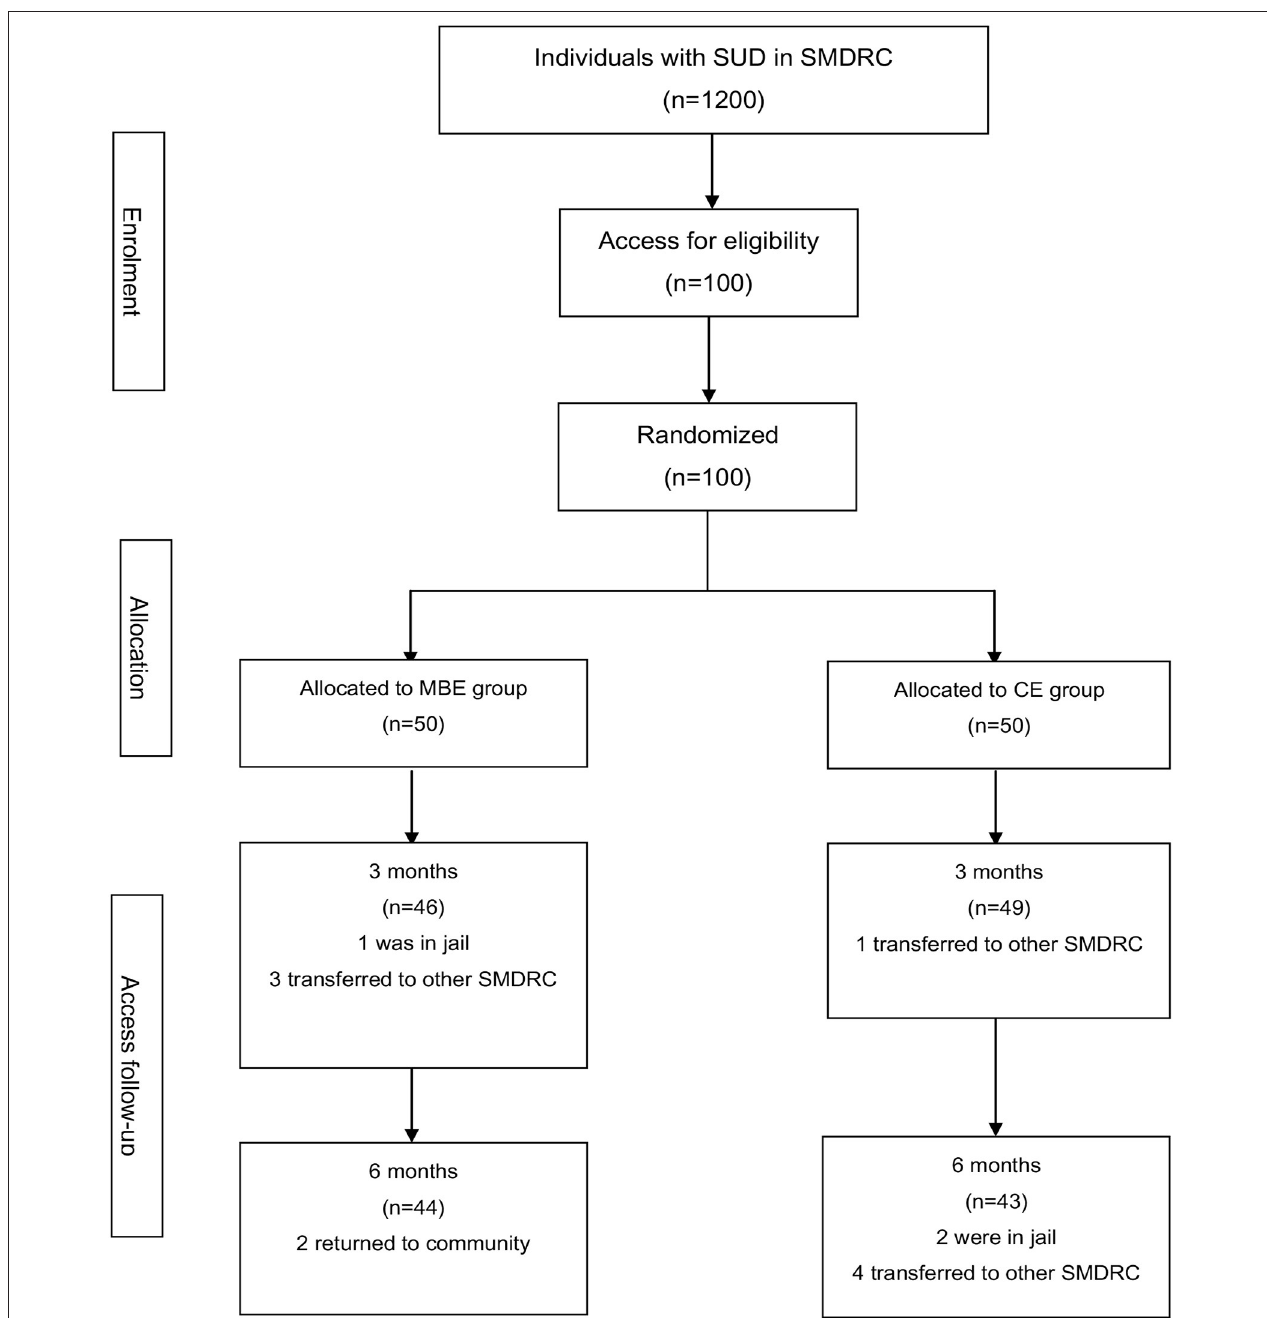
FIGURE 1 | Flow diagram of the intervention progress through the phases of the two groups.